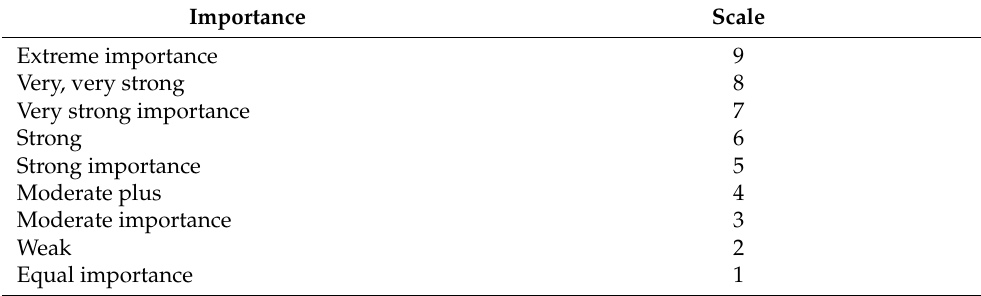
Table 1. Saaty’s scale of relative